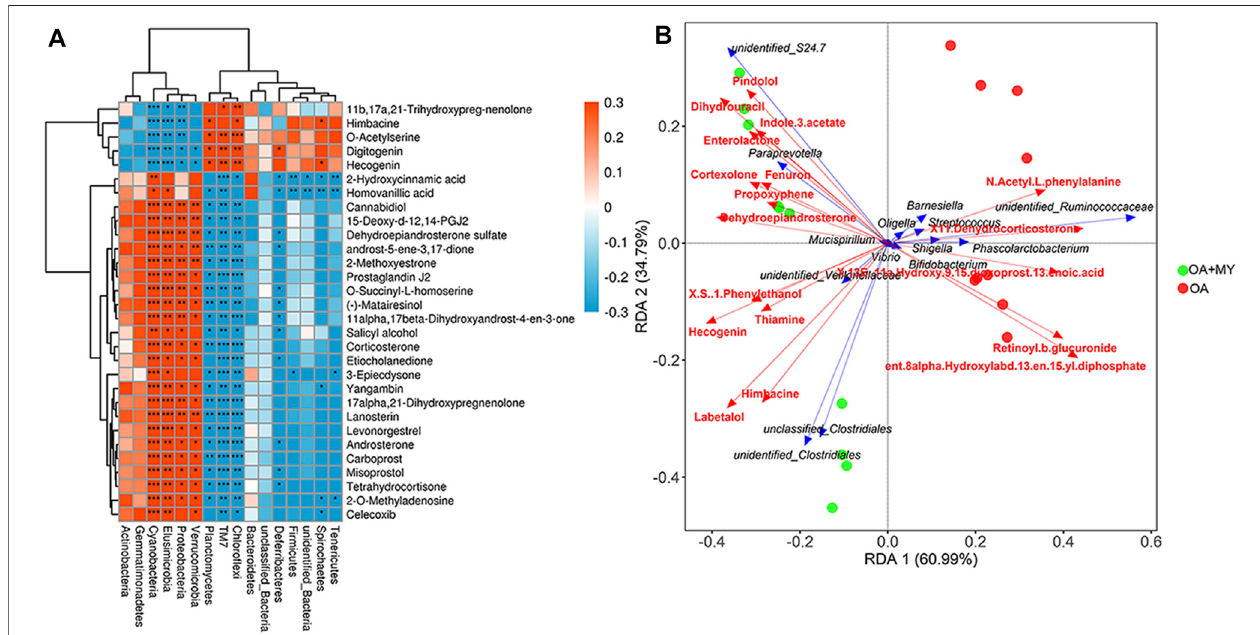
FIGURE 5 | Integrative analysis of 16S rDNA sequencing and metabolomics. (A) Associated heat map between the fecal bacteria at the phylum level and top 30 differentialmetabolites.Differentcolorsanddepthrepresentthesizeofthecorrelationcoef fi cient.Redandbluerepresentpositiveandnegativecorrelations,respectively. Adarkercolorindicatesahigherthecorrelation.*:0.01 < p < 0.05;**:0.0001 < p < 0.01;***: p < 0.0001. (B) Redundancyanalysis(RDA)ofspeci fi cgutmicrobiota atthe genuslevelrespondingtometabolites.Anacuteanglebetweentwovariablesrepresentsapositivecorrelation,thatis,asynergisticeffect.Anobtuseanglebetween two variables indicates a negative correlation, that is, an antagonistic